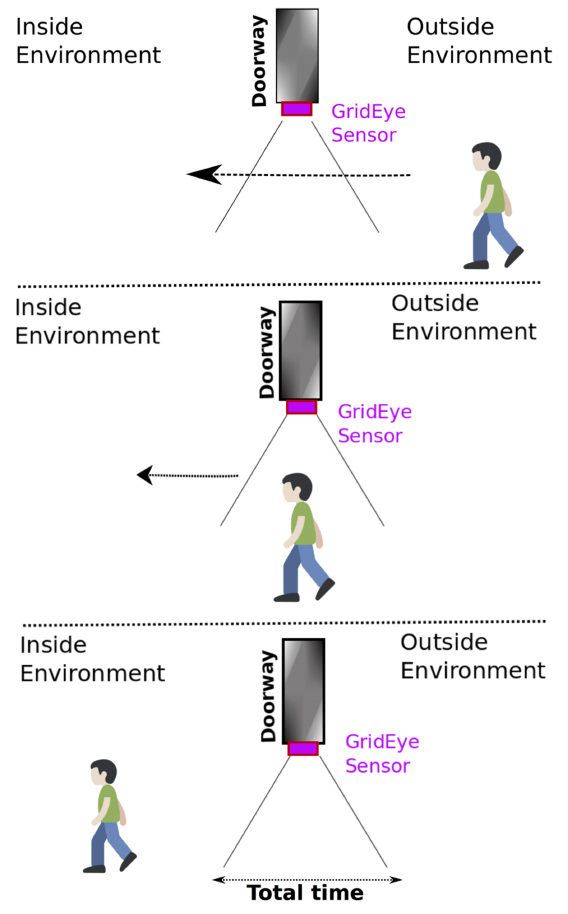
Figure 7. Depiction of a user crossing the doorway with the IR sensor set-up placed on the